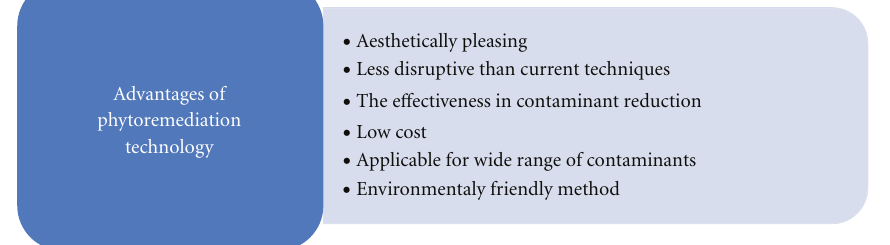
Figure 7: Advantages of phytoremediation technology.